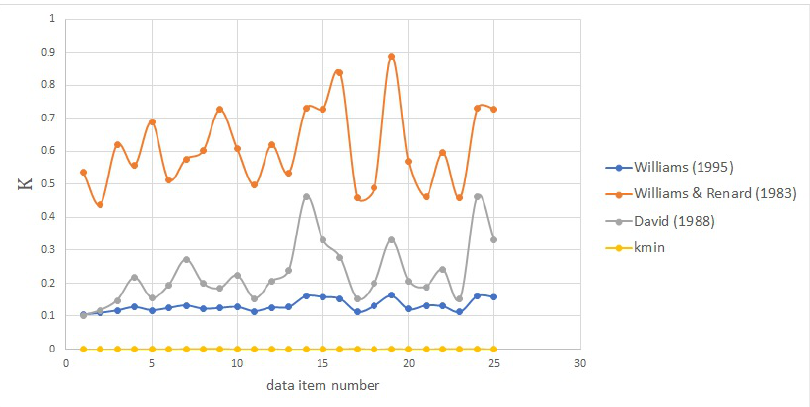
Figure 18. K -factor graphs of different soil types, which represent any of the four watersheds under our